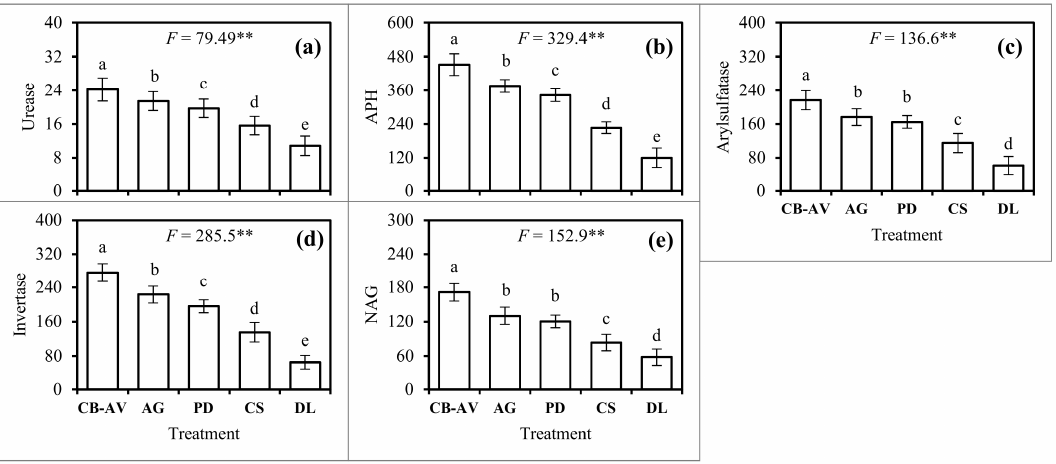
Figure 6. Mean values and standard deviation (SD) of soil enzyme activity in the different treatments of tree species. Results of the ANOVAs ( F test and p value) are given. Different letters after means within each treatment indicate significant differences by Duncan’s test ( p < 0.05). Note: ** p < 0.01.